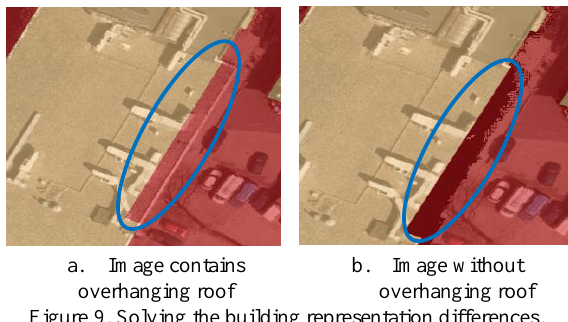
Figure 9. Solving the building representation